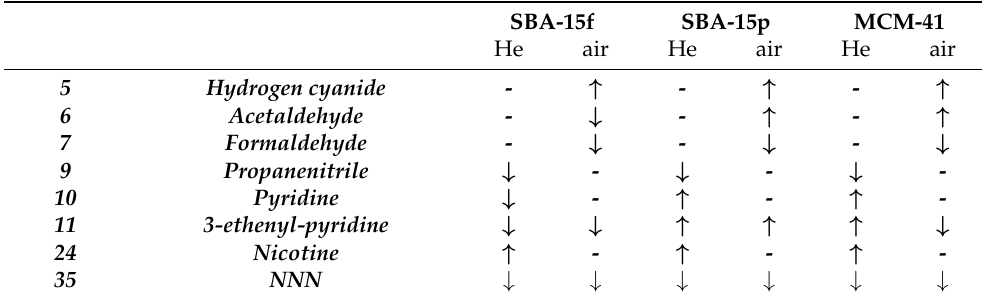
Table 2. Toxic compounds present in the gas generated in the pyrolysis of NNN under both